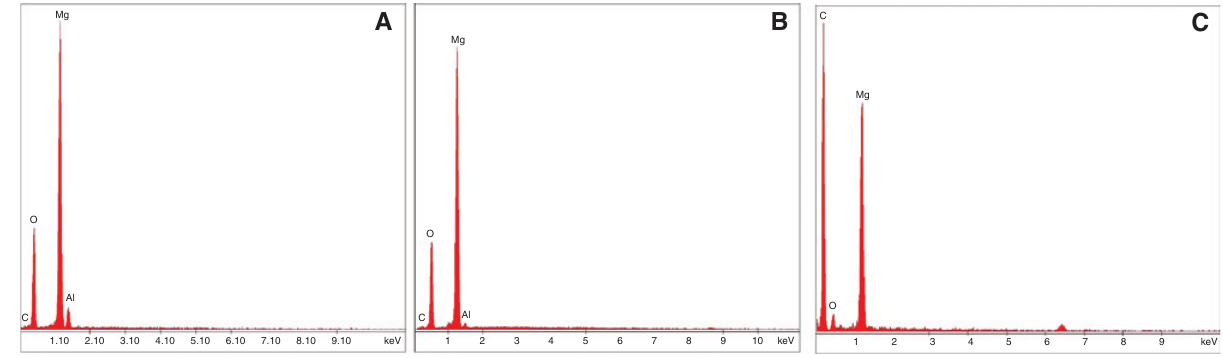
Figure 4 EDS images of AZ31-MWCNT composites: (A) 0.33 wt%, (B) 0.66 wt%, (C) 1.0